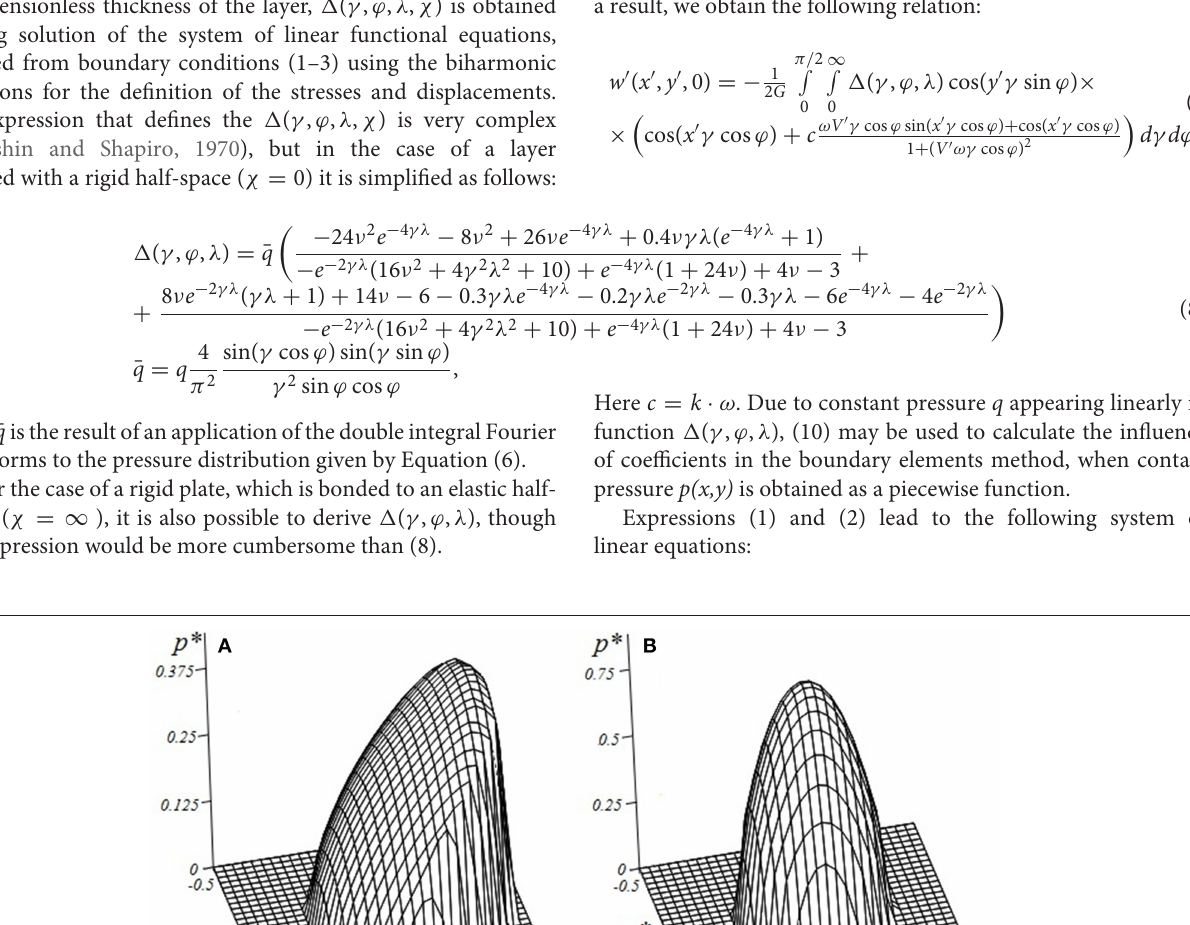
Frontiers in Mechanical Engineering |